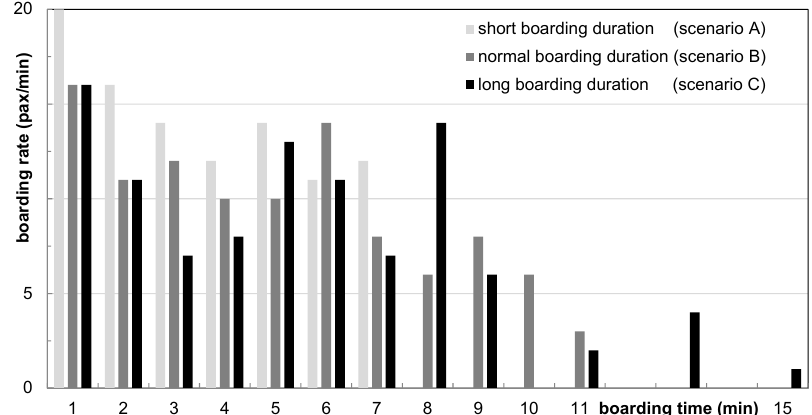
Figure 8. Boarding progress of one specific flight on different days of operations.